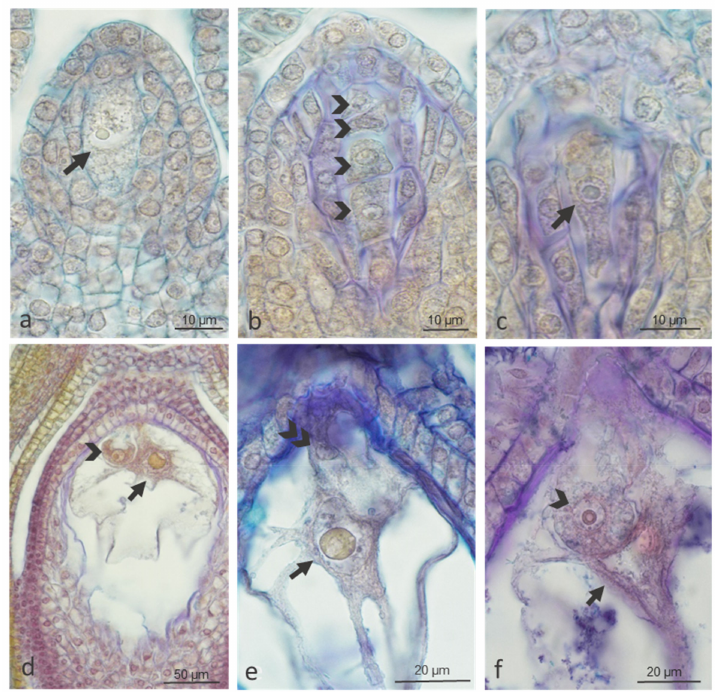
Figure 2. Proper megasporogenesis and female gametophyte development (megagametophytogenesis) at three stages of flower development in ‘Panda’ and PA15 genotypes of common buckwheat under control (20 ◦ C) and thermal stress (30 ◦ C) conditions. Megaspore mother cell in prophase I in ‘Panda’ bud at 20 ◦ C (arrow, a ), tetrad of megaspores in ‘Panda’ bud at 20 ◦ C (each of four cells marked with arrowhead, b ), 1-nucleate embryo sac of PA15 at 20 ◦ C (arrow, c ), central cell (arrows), egg cell (arrowheads), one of the two synergids (double arrowhead) of 7-celled embryo sac in open and wilted flowers ( d – f ) of ‘Panda’ at 30 ◦ C ( d ), ‘Panda’ at 20 ◦ C ( e ), and PA15 at 30 ◦ C ( f ). Paraffin sections stained with Ehrlich’s hematoxylin combined with Alcian blue. The number of analyzed flowers per treatment at each stage of development was 15–32 in two replicates. Table 1. Percentage [%] of properly developed embryo sacs of cv. ‘Panda’ and strain PA15 at two temperatures. cv. ‘Panda’ PA15 Organ 20 ◦ C 30 ◦ C 20 ◦ C 30 ◦ C Buds 100.0 57.7 * 83.3 79.5 Open flowers 88.2 44.4 * 77.8 26.7 * Wilted flowers 83.3 80.0 81.3